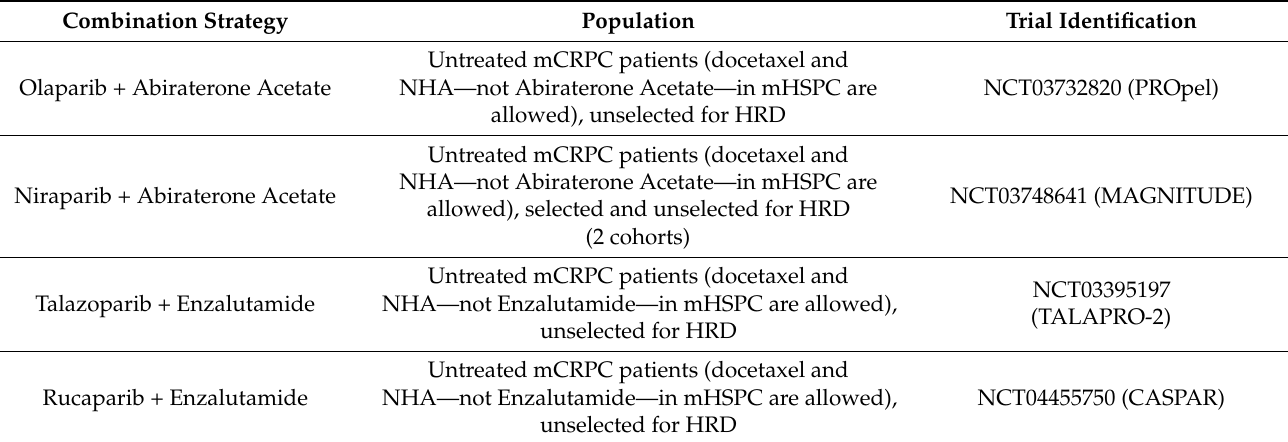
Table 4. Ongoing phase III trials of PARP inhibitor in combination with novel hormonal agent